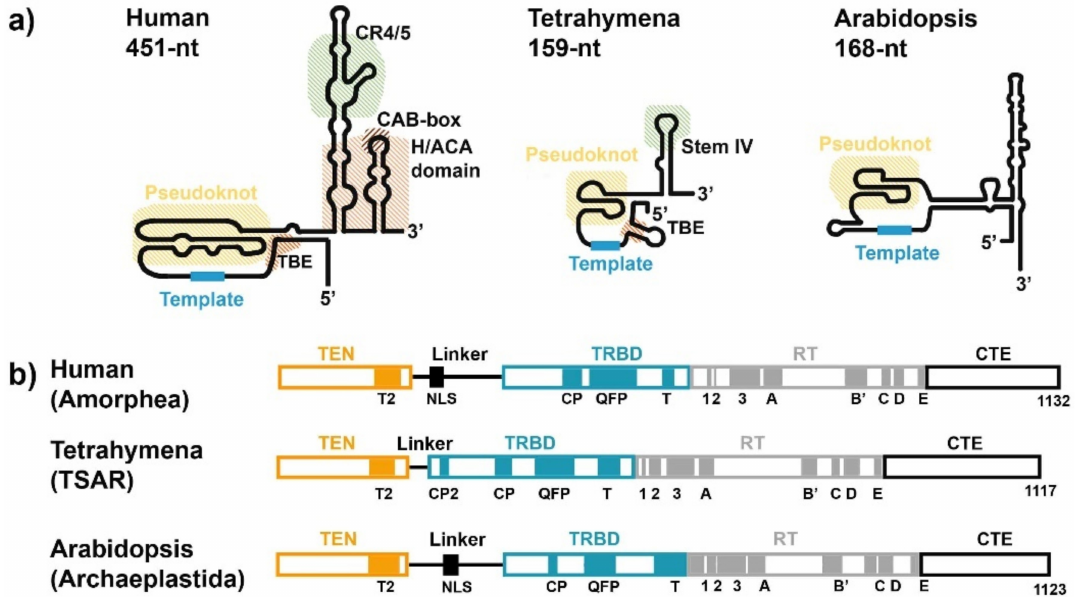
Figure3. Conservationoffunctionaldomainsoftwocoretelomerasesubunits—TERTandTR.( a )Models of secondary structures of human, Tetrahymena and Arabidopsis TRs suggest the conservation of several structural motives, including pseudoknot in the vicinity of the template (t / PK domain) and stem-loop regions [70,71]. In humans the stem-loop region contains the conserved 4 / 5 (CR4 / 5) region, the H (AnAnnA) and ACA-boxes (H / ACA) domains and the Cajal body box (CAB-box) motif that serve as binding sites for other protein components of the telomerase holoenzyme complex (dyskerin, NOP10, NHP2 and GAR1). In Tetrahymena, the stem-loop 4 (SLIV) is directly bound by p65 protein [72]. To date, particular interactors and their binding sites have not been demonstrated directly in Arabidopsis (see also Table 1). ( b ) Domain arrangement of human (animals), Tetrahymena (ciliates) and Arabidopsis (plants) TERTs. The supergroup for each species is given (see Figure 2). N-terminus: the